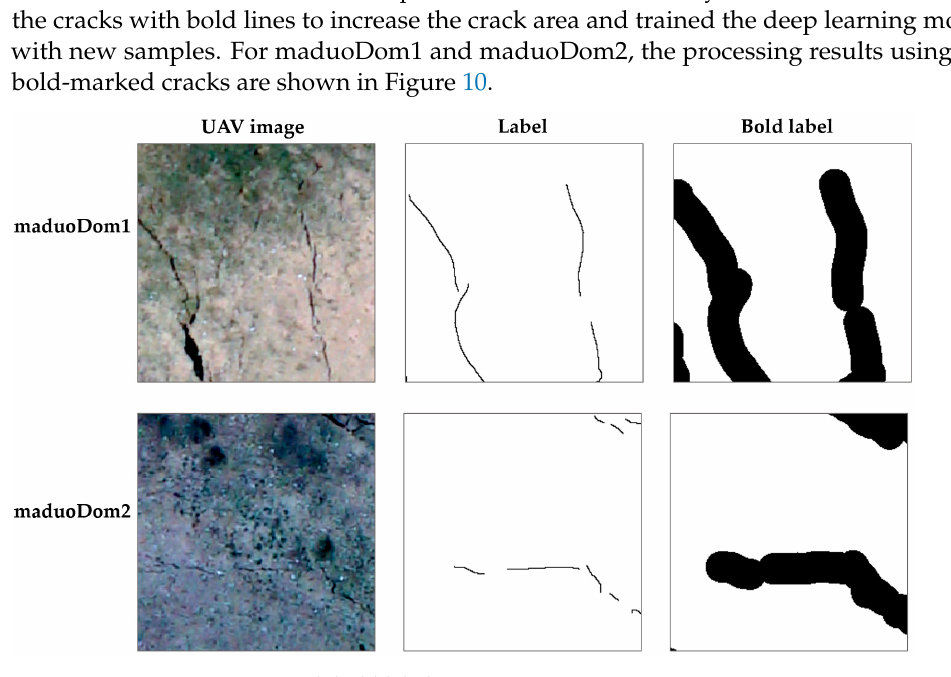
Figure 10. Data processing with bold labels.